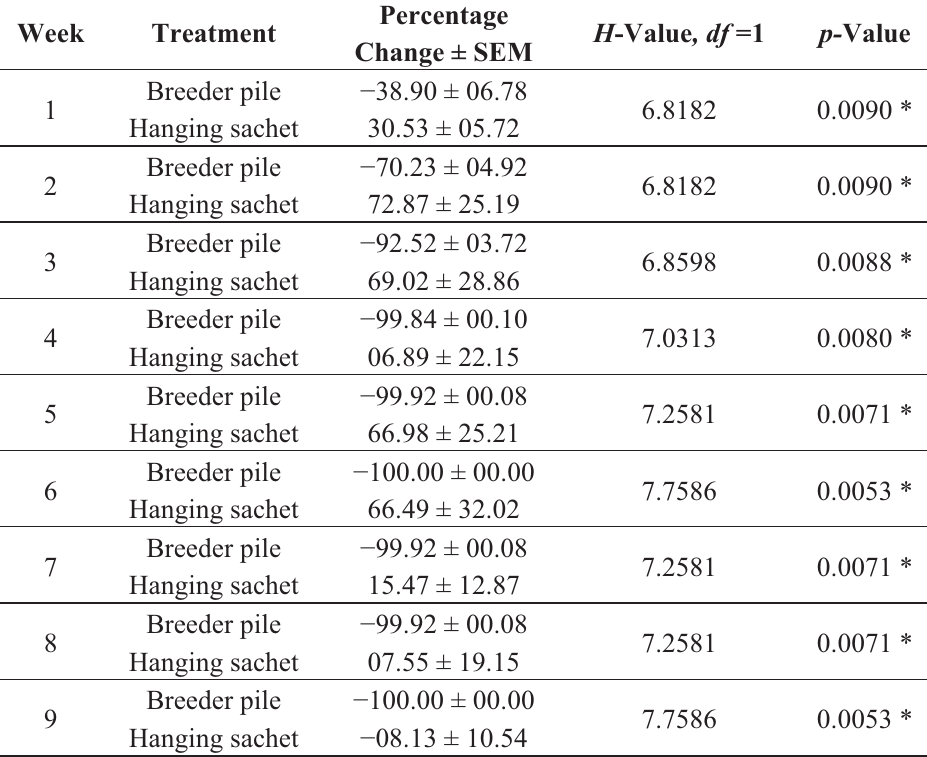
Table 2. Percentage change ± SEM of mean N. cucumeris densities in treatments after introduction in experiment 1, trial 2. * indicates significant differences between treatments (Kruskal- Wallis, α = 0.05).